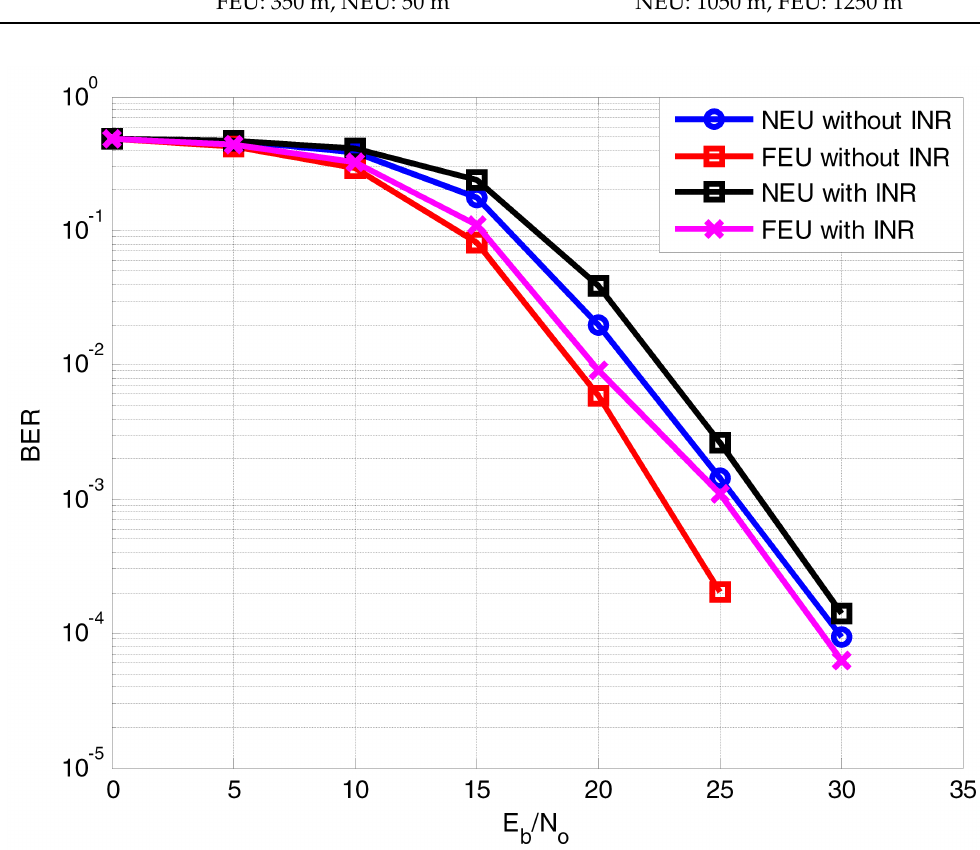
Figure 15. BER performance comparison of perfect SIC for NEU and FEU in the presence of intercell